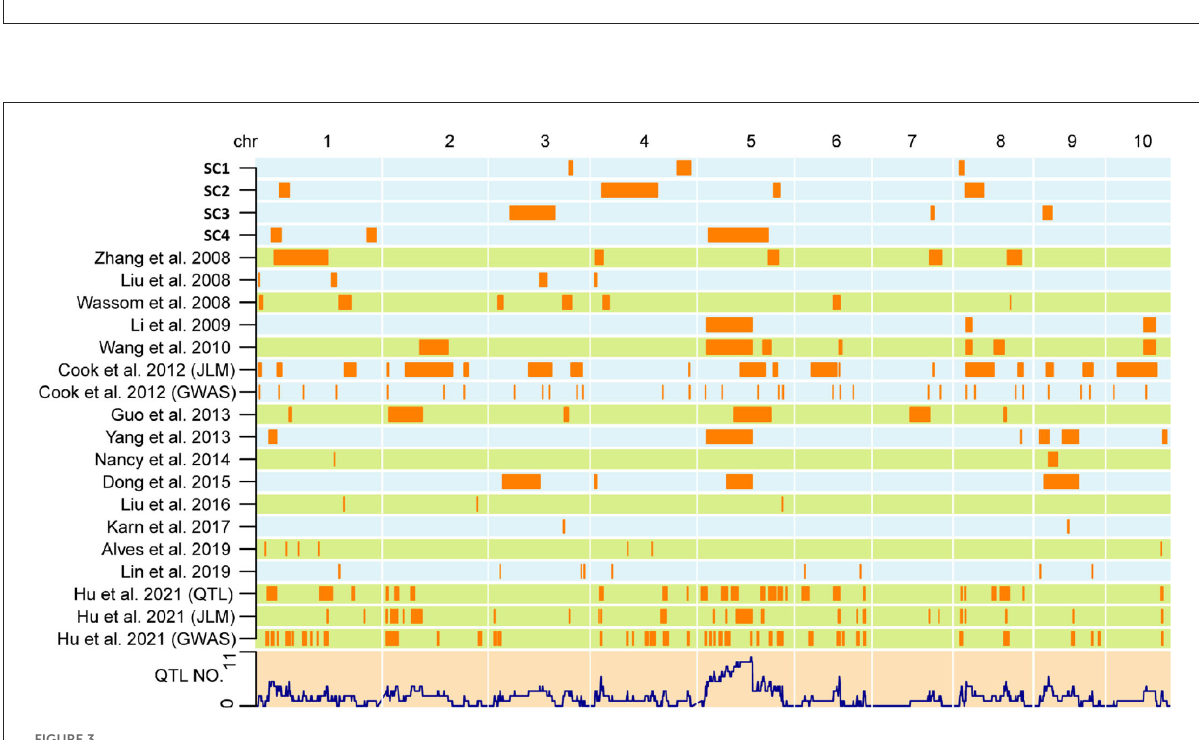
FIGURE2 The distribution of SC quantitative trait loci (QTLs) across the entire genome in the four DH populations. The upper of each picture displays a logarithm of the odds (LOD) score (y-axis) against the physical position (x-axis) of markers, while the bottom of the picture displays the additive effect (y-axis) against the physical position (x-axis) of markers. (A–D) designated SC1, SC2, SC3, and SC4, respectively.